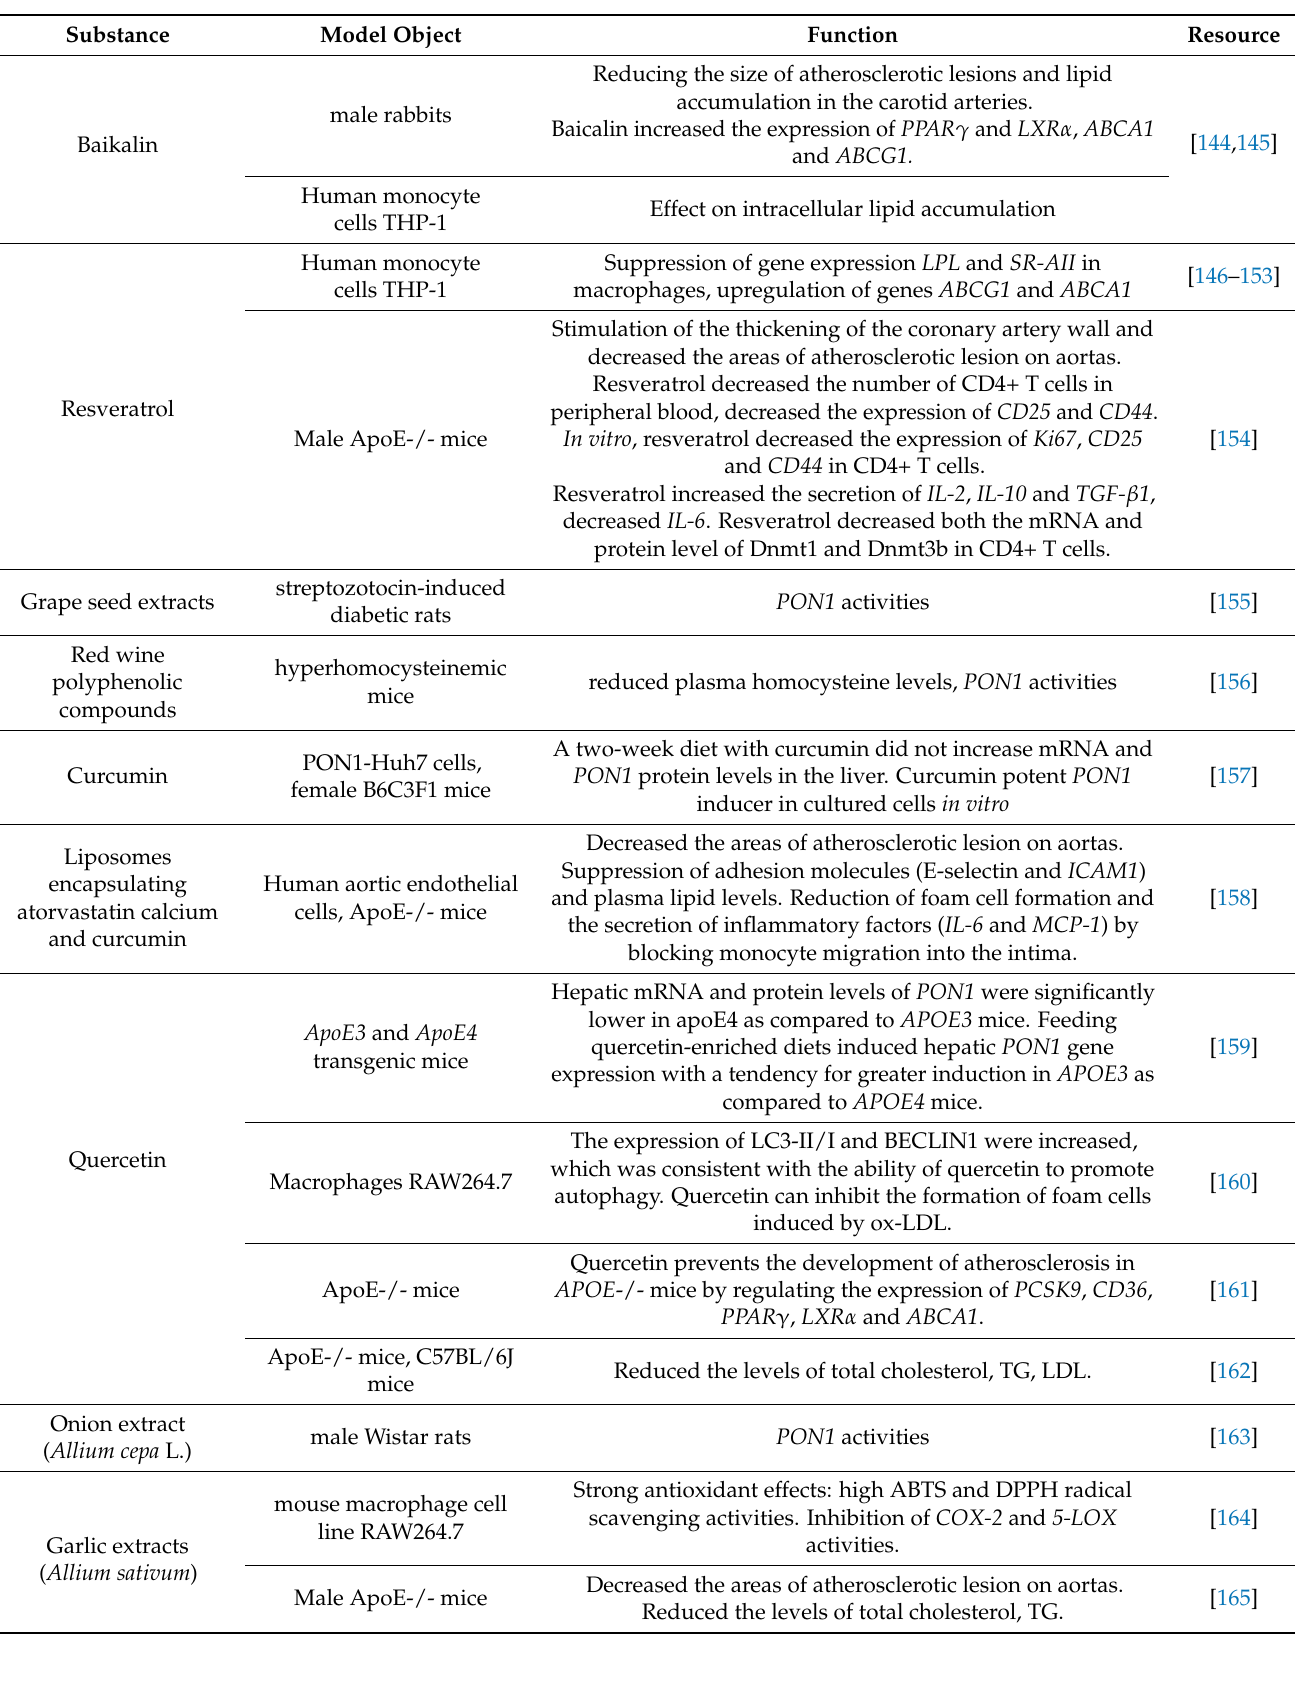
Table 1. List of plants and their metabolites showing cardioprotective